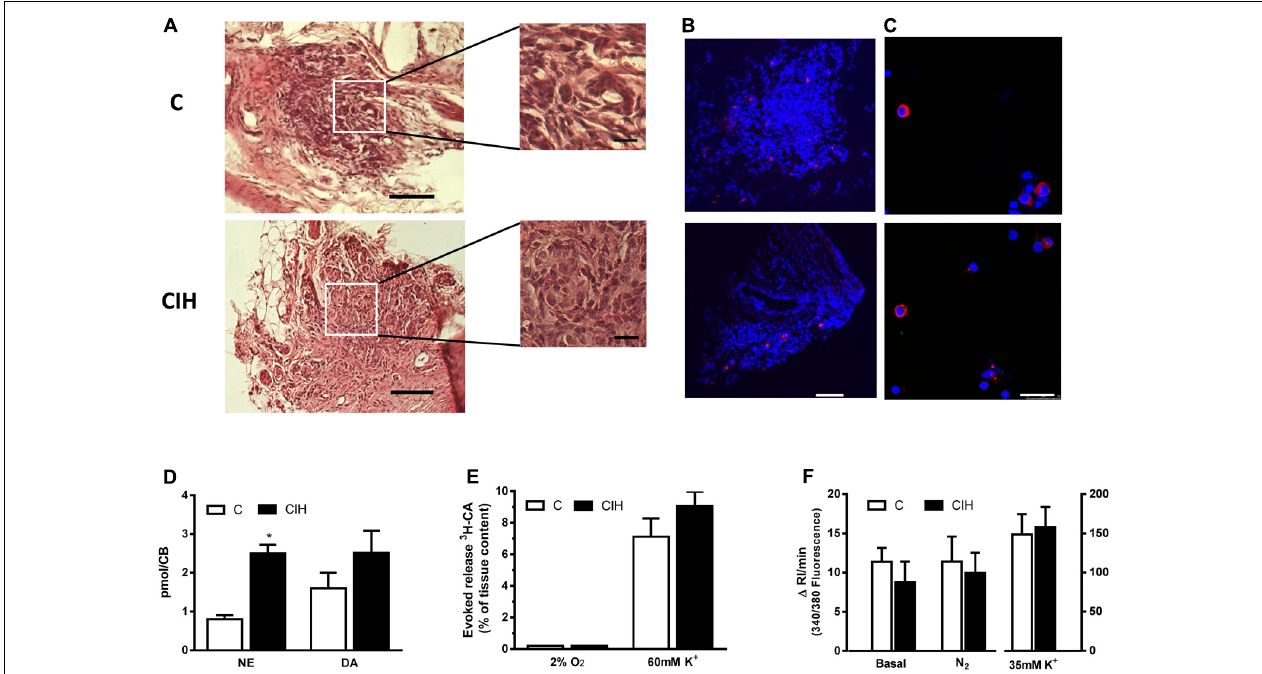
FIGURE 3 | CB morphology and stimuli-dependent response from control and CIH guinea pig. (A) Hematoxylin and eosin staining of a guinea pig CB section (control on top, CIH on bottom); calibration bar 100 µ m (20 µ m in inserts). (B) Immunohistochemical tyrosine hydroxylase (TH; red) and DAPI (blue) cell identification from slices of control (top) and CIH (bottom) CB; calibration bar 100 µ m. (C) Immunocytochemical TH (red) and DAPI (blue) identification of isolated control (top) and CIH (bottom) guinea pig CB cells. Calibration bar 25 µ m. (D) Endogenous content of norepinephrine (NE) and dopamine (DA) expressed as pmol/CB in control and CIH animals measured by HPLC-ED; ∗ p < 0.05 CIH vs. C; Data are mean ± SEM ( n = 8–12); Two-way ANOVA with Sidak’s multiple comparison test. (E) Evoked release of 3 H-CA from control and CIH CB in response to 2%O 2 or high-external K + (60 mM). Data are mean ± SEM ( n = 6); Two-way ANOVA with Sidak’s multiple comparison test. (F) Mean intracellular calcium levels, expressed as the increase in the integrated response per minute, in control and CIH chemoreceptor cells under basal conditions and in response to severe hypoxia (5% CO 2 /95% N 2 ) or 35 mM K + . Data are mean ± SEM ( n = 28–33); Two-way ANOVA with Sidak’s multiple comparison